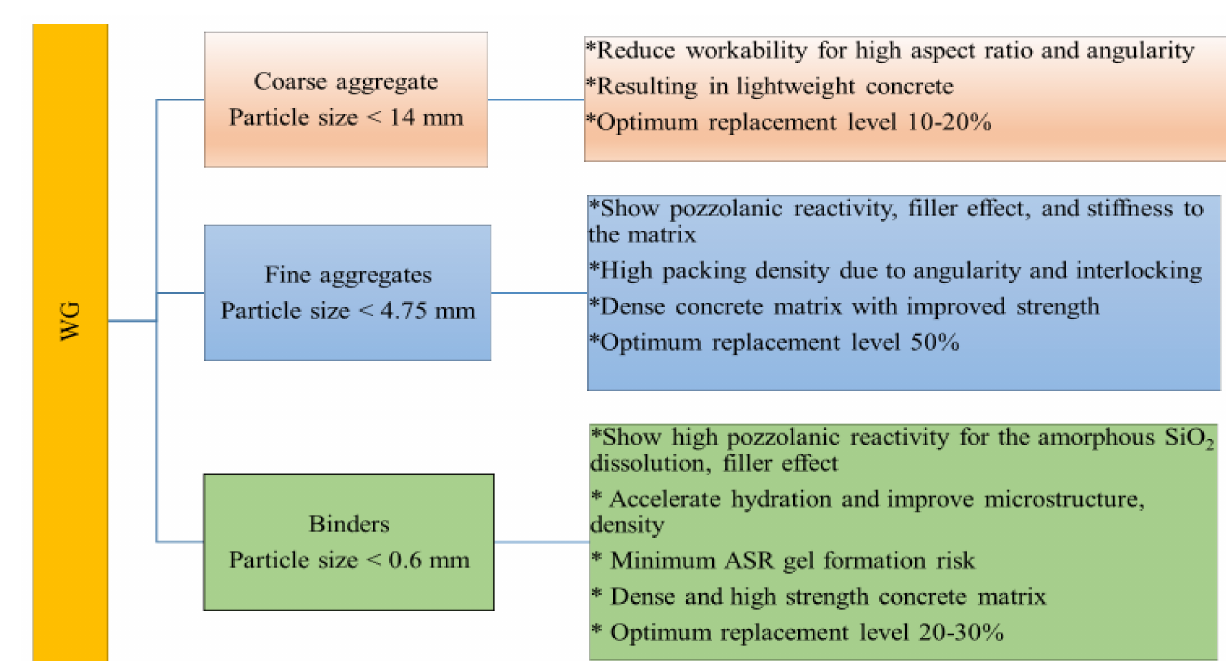
Figure 16. Performance and optimum replacement level of WG in cement concrete according to particle size and role